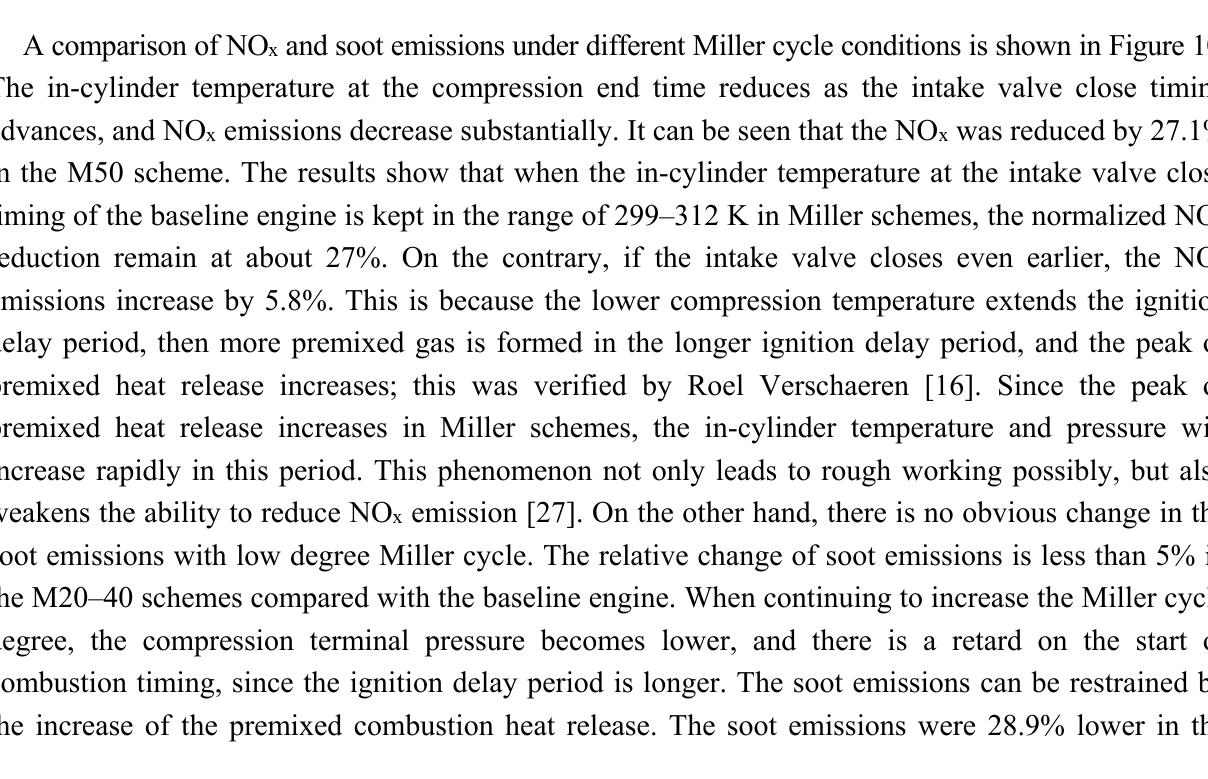
Figure 9. Comparison between Miller and base schemes in effective compression and boost